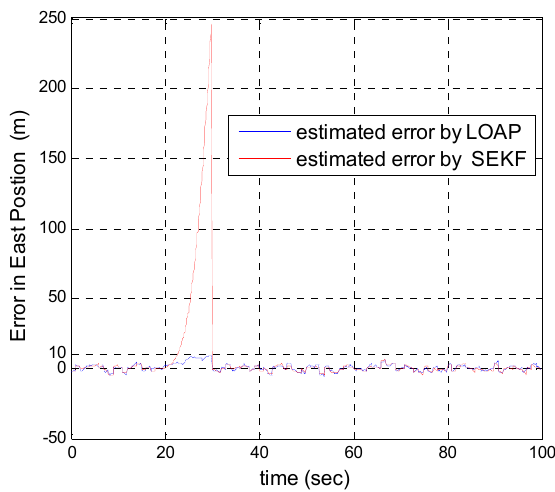
Figure 12. Error estimation of east position.